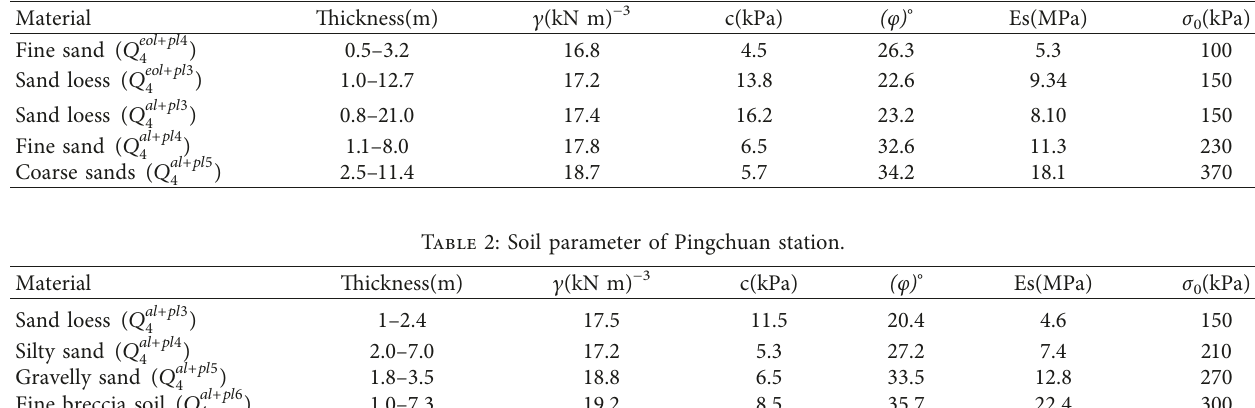
spectively. Figure 1 is the measured fill height-time- settlement curve.